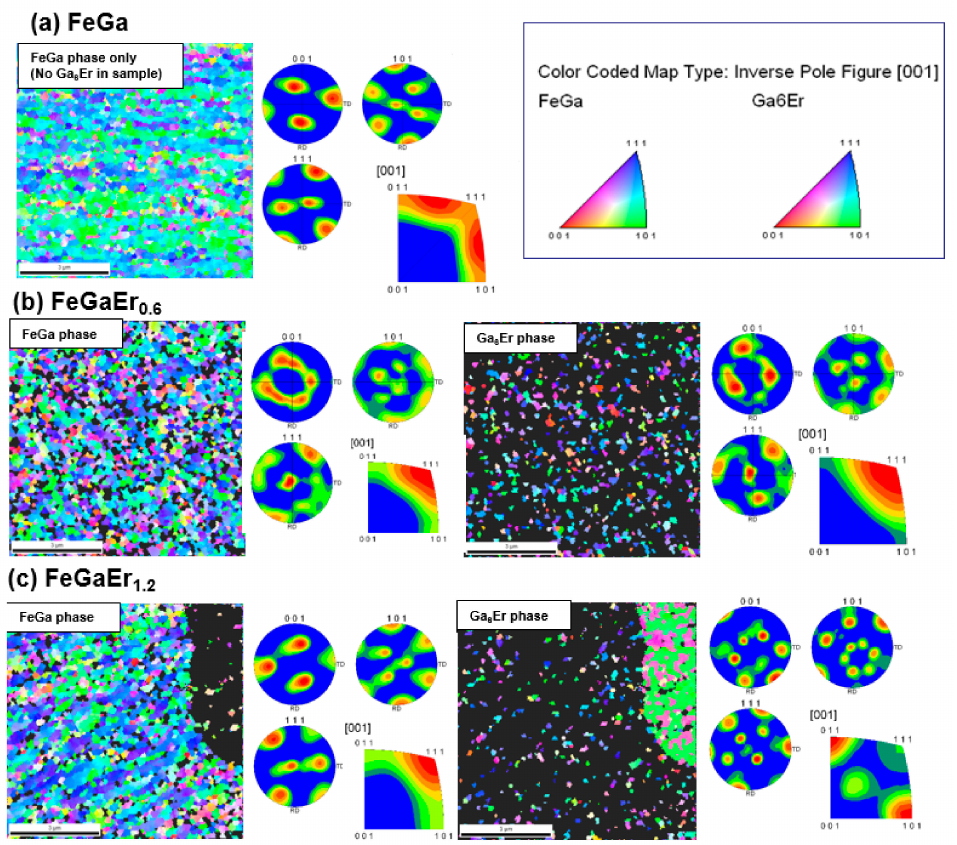
Figure 4. Inverse pole figure maps and corresponding pole figures for FeGa and the Ga 6 Er phases in samples of the following compositions: ( a ) Fe 83 Ga 17 (parent compound); ( b ) Fe 83 Ga 17 Er 0.6 and ( c ) Fe 83 Ga 17 Er 1.2 . The inverse pole figures shown here give the crystallographic orientation of the grains, according to the stereographic triangles for each phase.